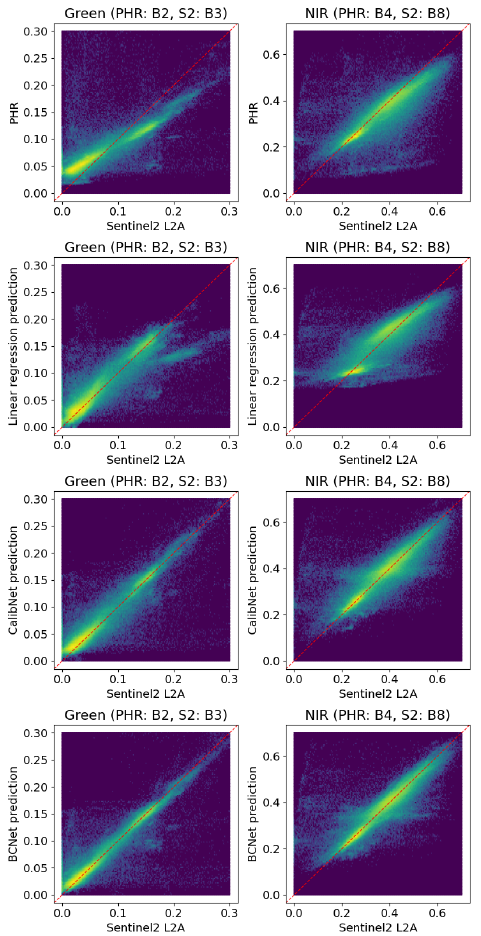
Figure 17. Scatter plot between Pleiades and Sentinel-2 surface reflectance for the Bretagne2 dataset, where the Pleiades image is contaminated by unmasked clouds, for all methods, using variance prediction, for Green and NIR bands.